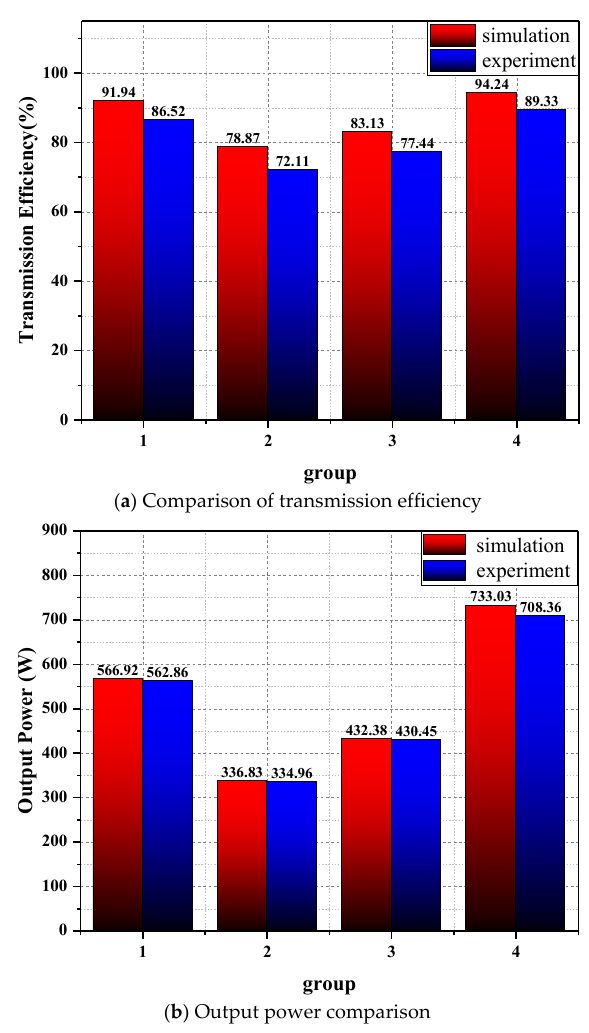
Figure 13. Experimental results of coupled coil interoperability.